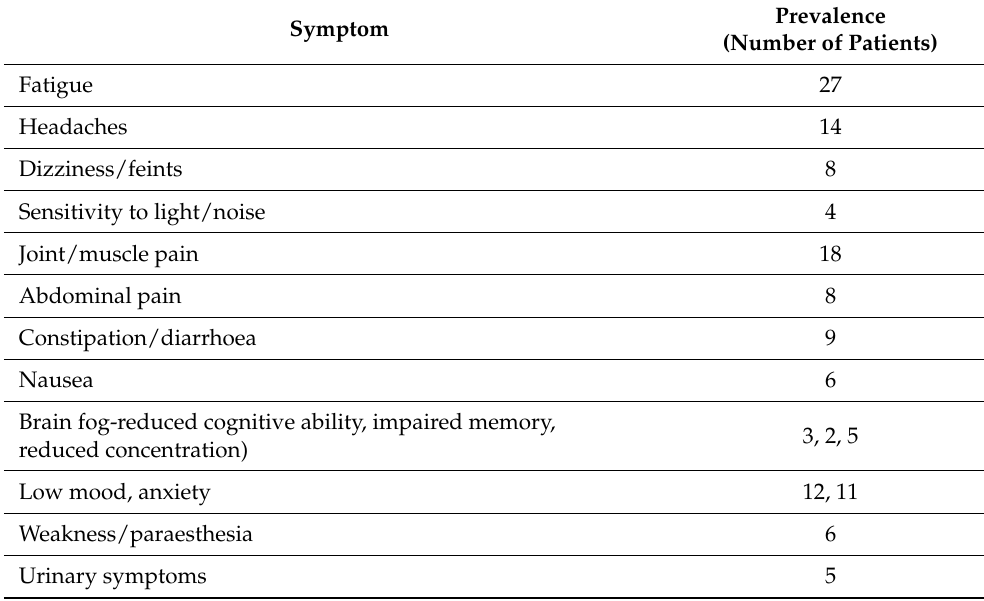
Table 3. Prevalence of Symptoms in cohort.